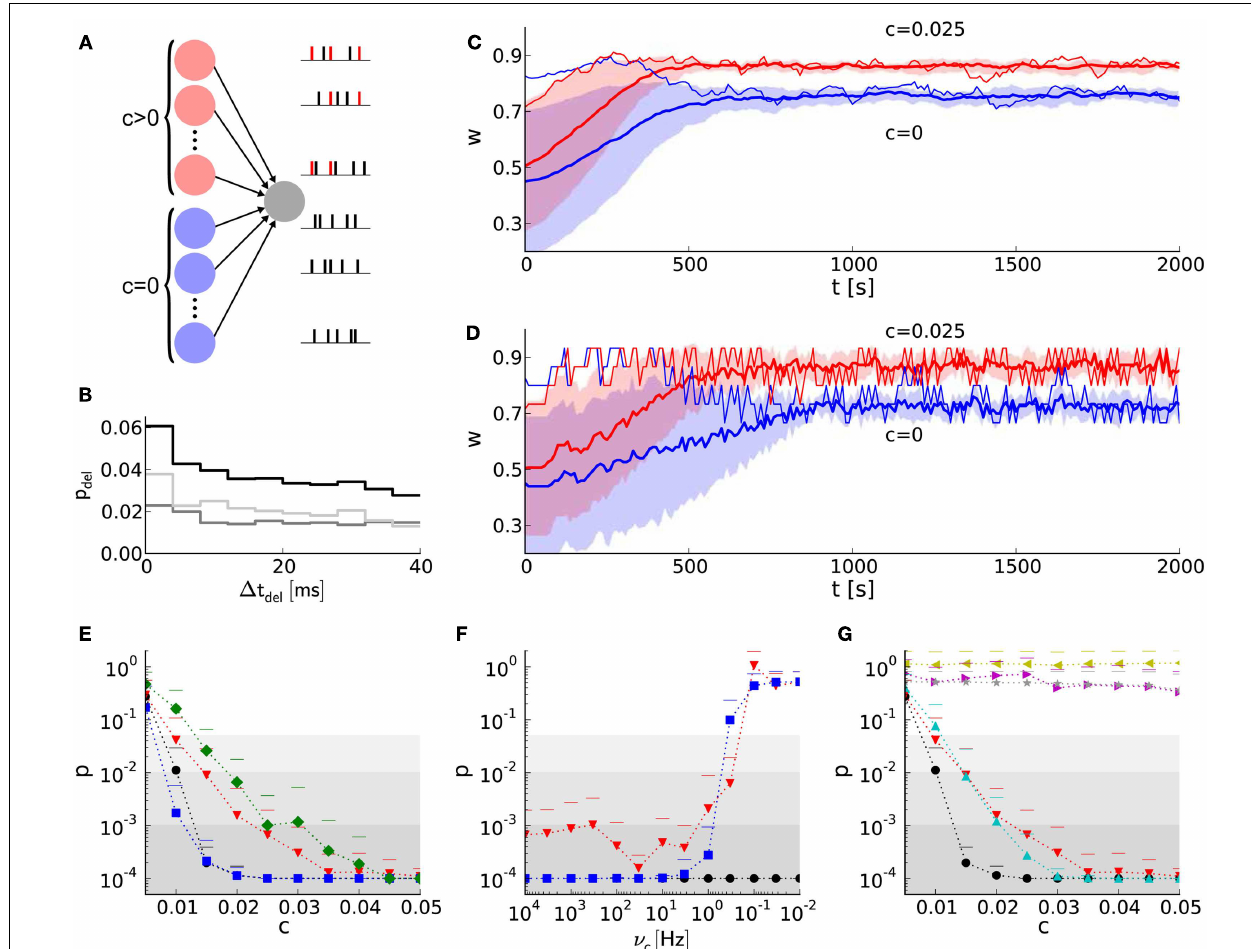
of having the same median of weights within both groups of synapses (with correlated and correlated input) at t = 2,000s versus the correlation coefficient c .The hardware-inspired synapses model is represented in red ( r = 4 bits and n = 36), green ( r = 4 bits and n = 36) and blue ( r = 8 bits and n = 12). Black depicts the reference synapse model ( r = 64 bits).The background shading represents the significance levels: p < 0.05, p < 0.01, and p < 0.001. (F) Dependence of the p -value on the update controller frequency v c for c = 0.025. Colors as in (E) . (G) Black and red trace as in (E) . Additionally, p -values for hardware-inspired synapses with common resets are plotted in yellow ( r = 4 bits and n = 36) and magenta ( r = 8 bits and n = 12). Compensations with ADCs are depicted in gray ( r = 4 bits and n = 15–45 in steps of 2) and cyan ( r = 8 bits and n = 1–46 in steps of